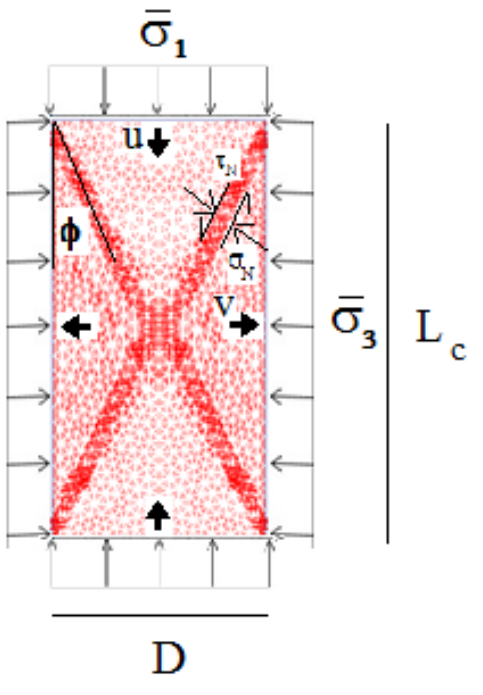
Figure 13. Failure mechanism in a confined concrete cylinder.